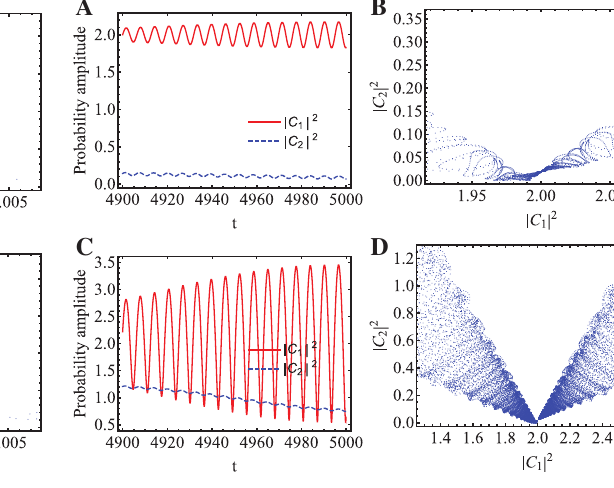
Figure 5: The probability amplitude evolution and the Poincare section under different coupling